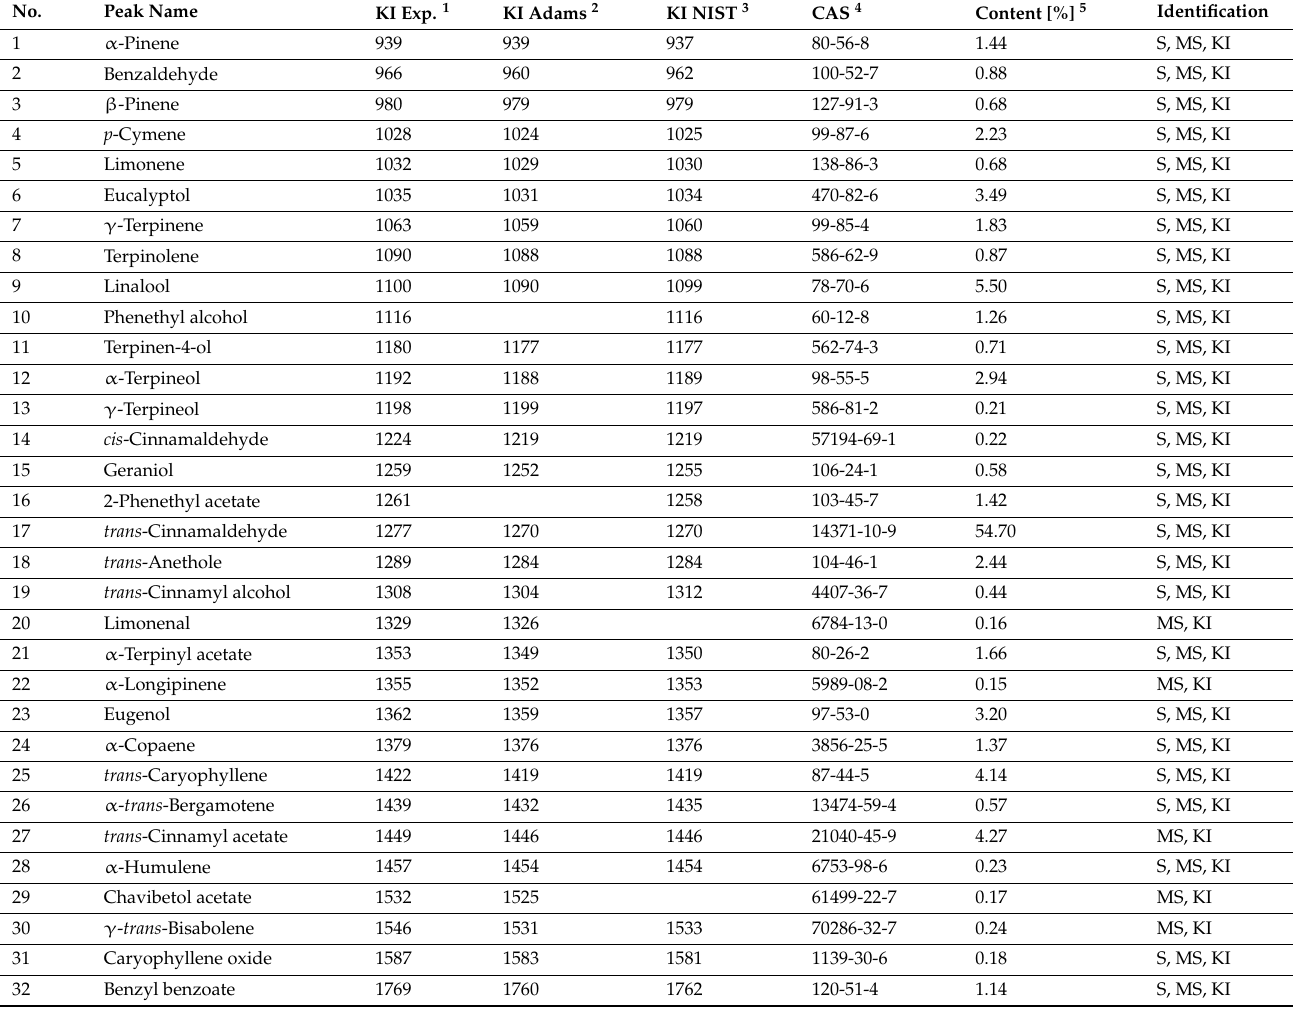
Table 13. GC-MS profile of Ceylon cinnamon essential oil .